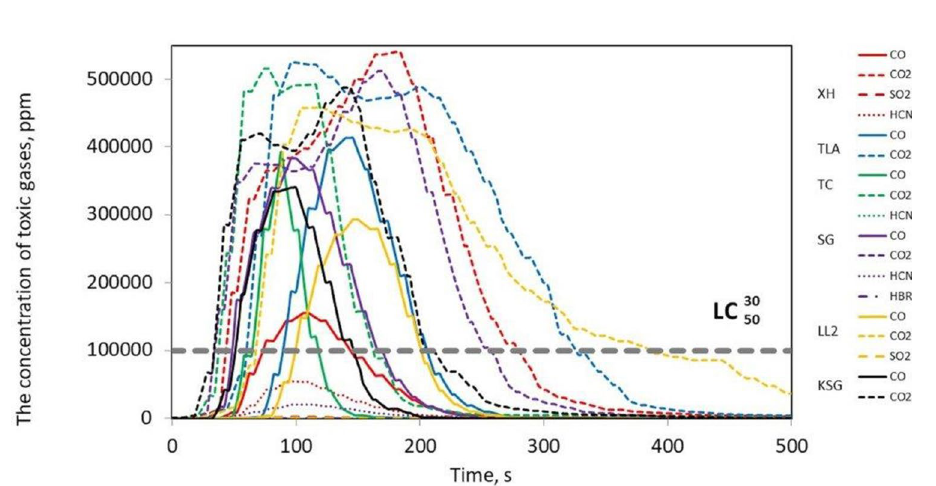
Figure 5. CO 2 concentration as a function of time during thermal decomposition and combustion of the tested belt samples with the indication of permissible values (Table